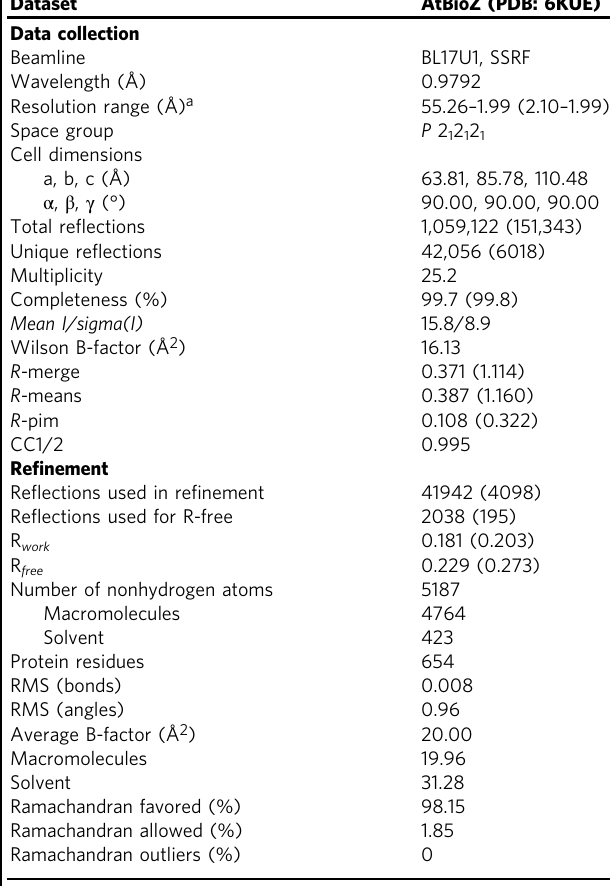
Table 1 X-ray crystallography data collection and re fi nement